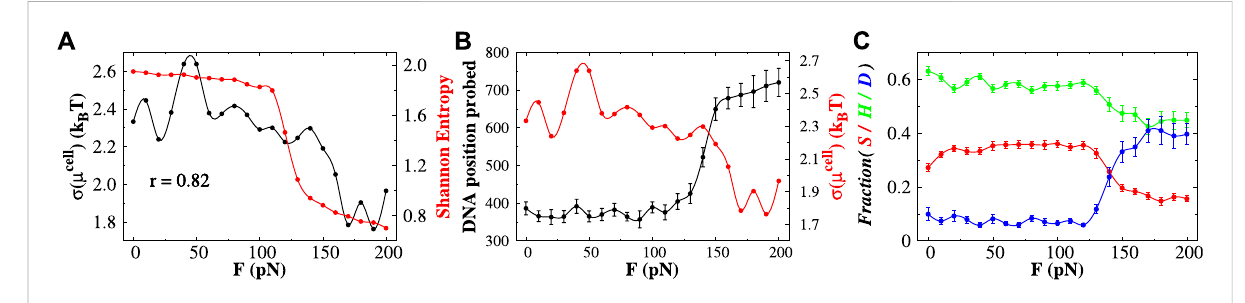
FIGURE 4 Effect of base-pair clusters on the diffusion of protein. (A) Correlations between the Shannon entropy H (denoted by the red line) and the roughness (standard deviation of μ cell ) of the chemical potential landscape (indicated by the black line) with the stretching force. The value of r indicates the correlation coef fi cient between them. (B) DNA position probed (black line) and the roughness of the chemical potential (red line) as a functionofstretchingforce. (C) Effectofstretchingforceontheinterplaybetweensliding (S),hopping(H),and3Ddiffusion(D)bythesearching protein. The error bar for each symbol is de fi ned as the standard error. In (A) and the red curve in (B) , the associated error bars are smaller than the point